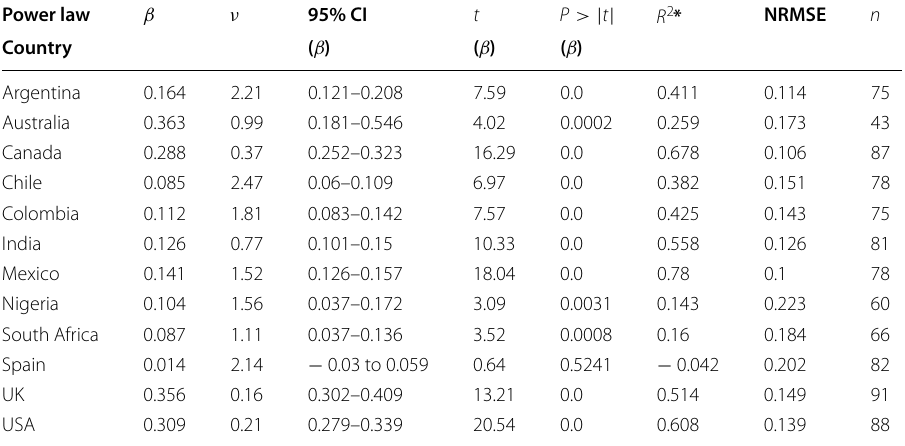
Table 4 The results from the fit of a power law [see Eq. (11)] to the relationship between the Death NLS and the national daily death